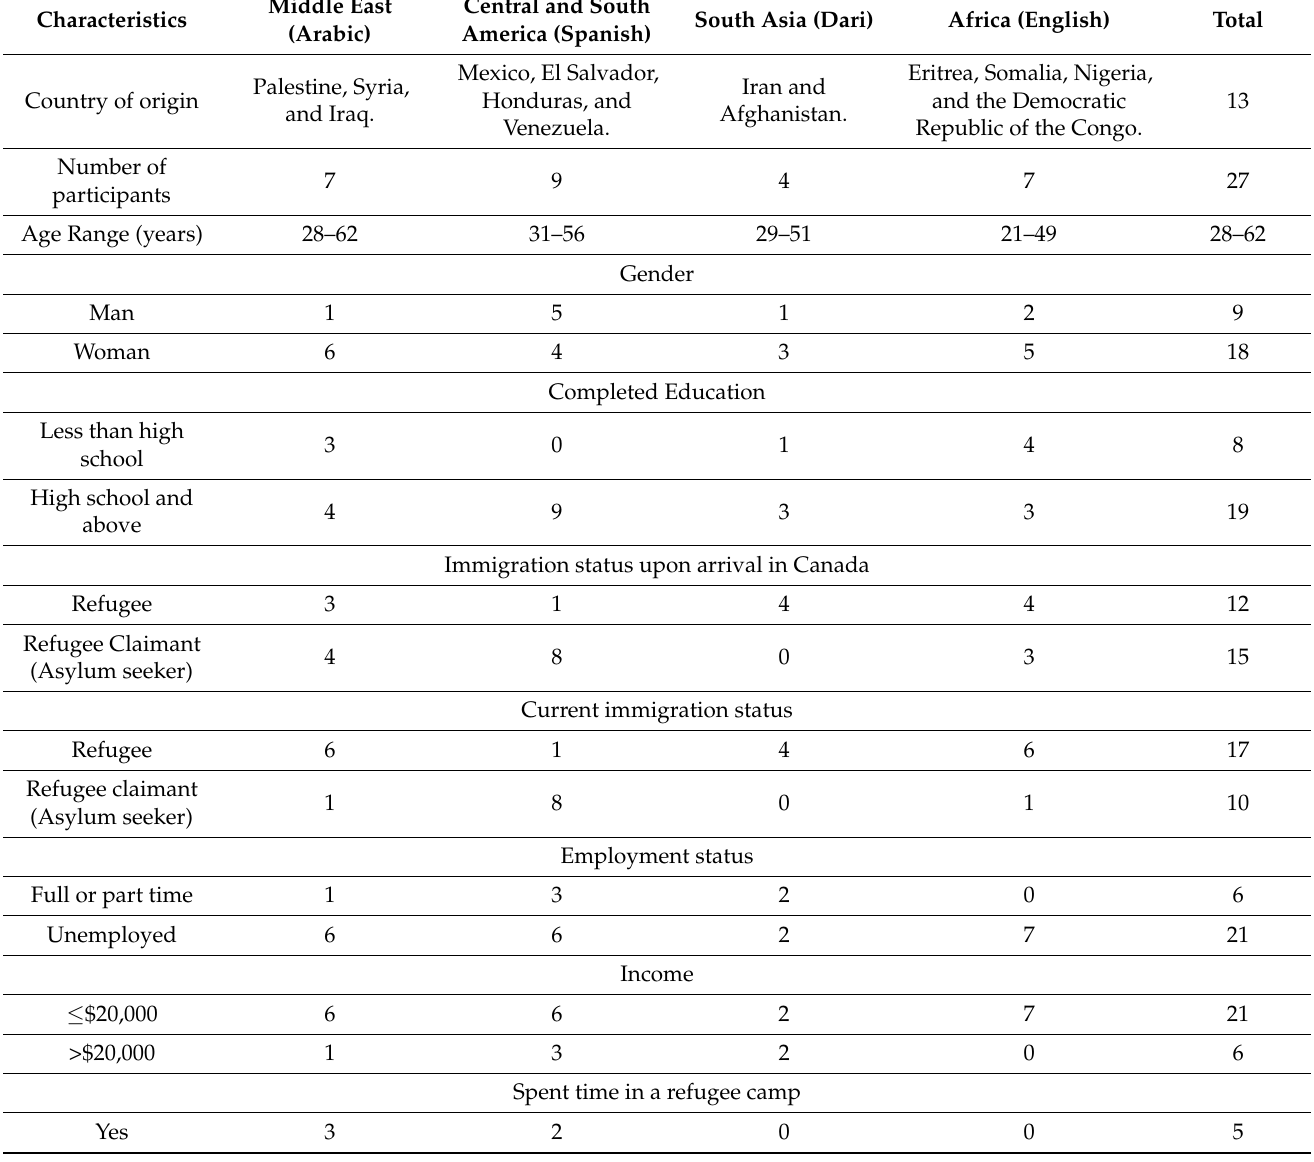
Table 1. Sociodemographic profile of study